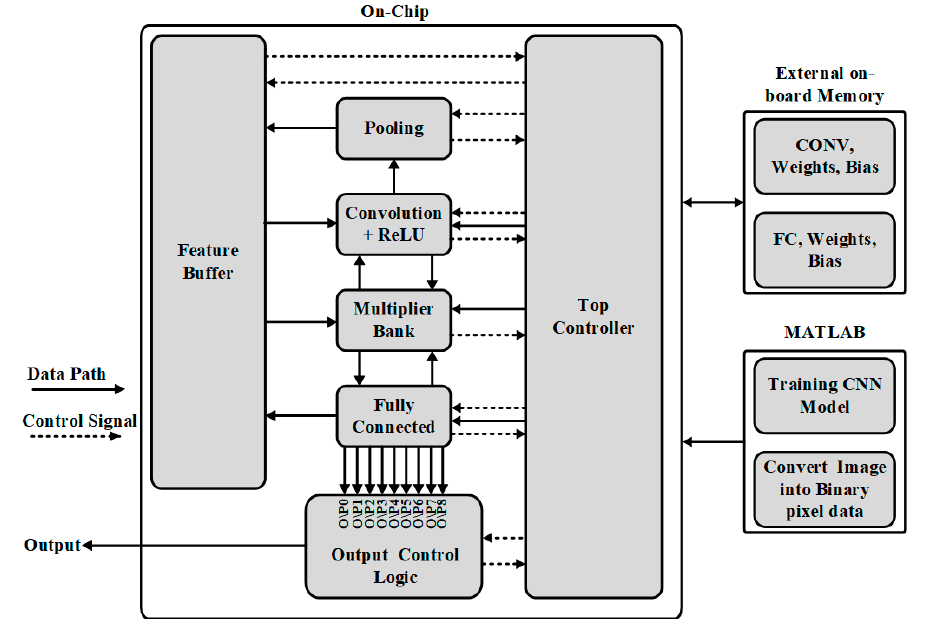
Figure 1. Top structure of CNN hardware implementation.